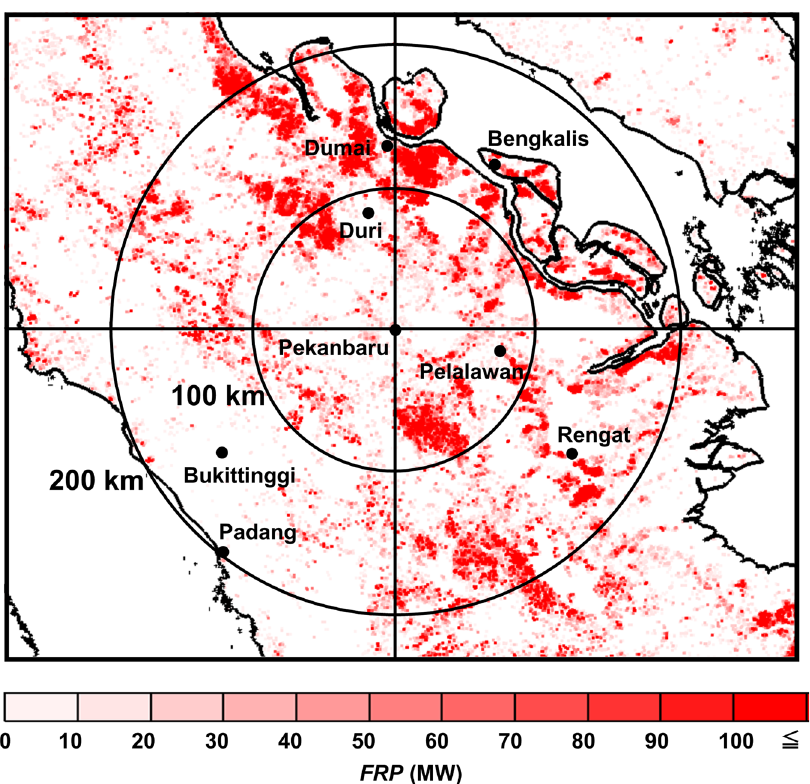
Fig. 1 Map of Fire Radiative Power (FRP) in the central region of Sumatra, Indonesia. Accumulated FRP for January 2009 – December 2018. Circles represent radii centered at Pekanbaru, capital of Riau